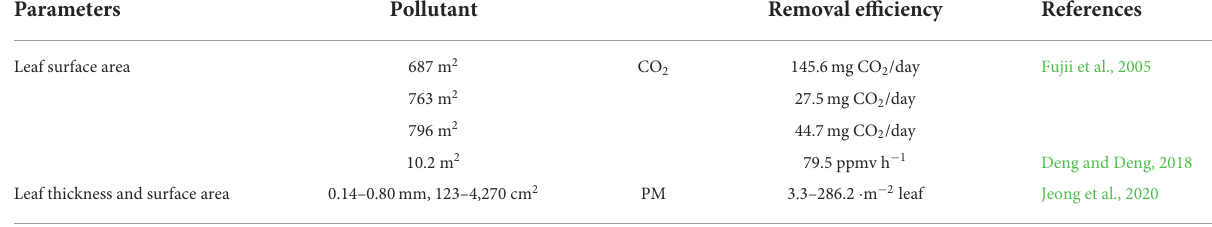
TABLE 2 Plant characteristics and their role in removing indoor air pollutants.